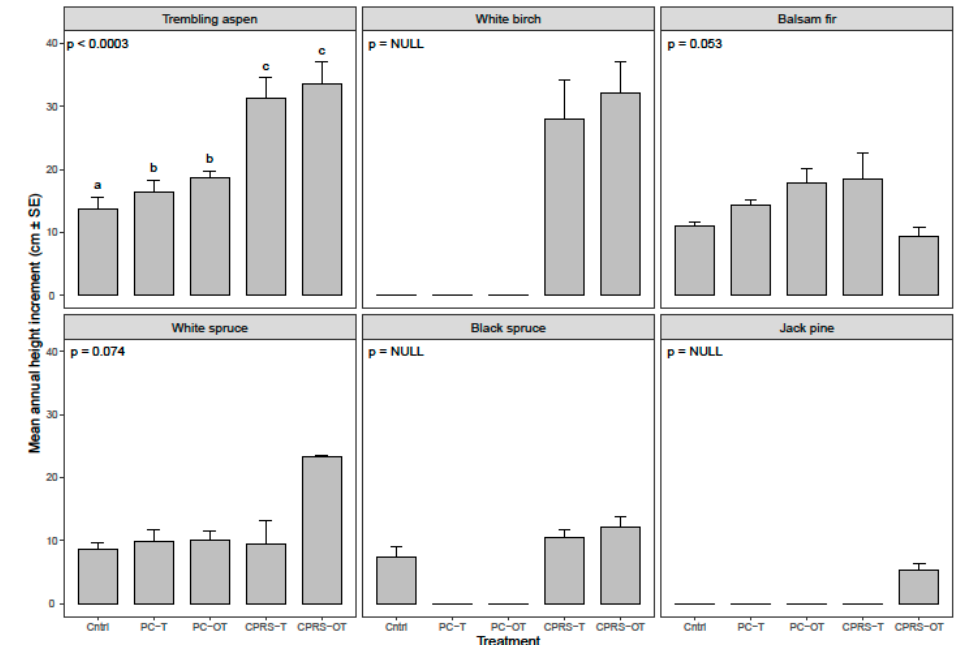
Figure 2. Mean regeneration annual height increment (cm ± Standard error) on and o ff machinery trails (190 micro-plots) across treatments and species 7 to 19 years after treatment in the boreal mixed-woods of eastern Canada. Bars with the same letter are not significantly different at alpha = 0.05, according to the Tukey HSD test. Treatments are Cntrl: unharvested control; PC: partial cut; CPRS: clear-cut with protection of regeneration and positions are T: machinery trails; OT: off machinery trails. See Table 4 for the number of observations.